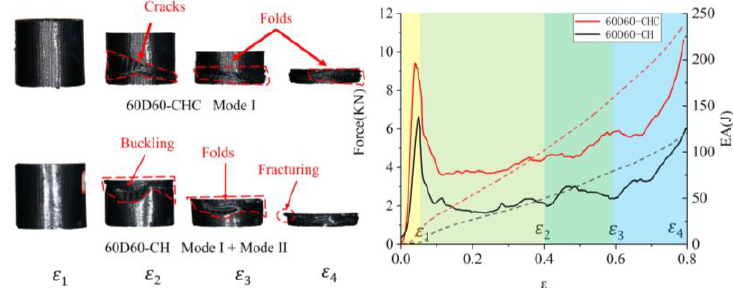
Figure 12. Failure mode and force – displacement curve of 60D60-CHC and 60D60-CH.